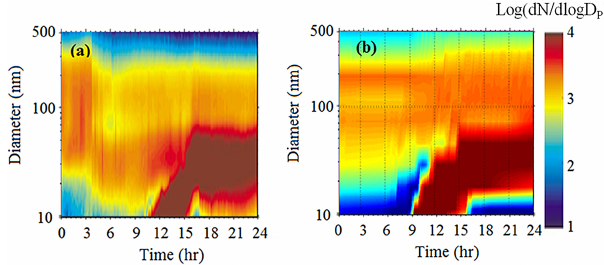
Figure 5. Comparison of (a) measured on 19 March 2009 (Pikridas et al., 2012) and (b) predicted dry size aerosol distribution (with bSOA aging and σ = 0.025Nm − 1 ) as a function of time at Fi-